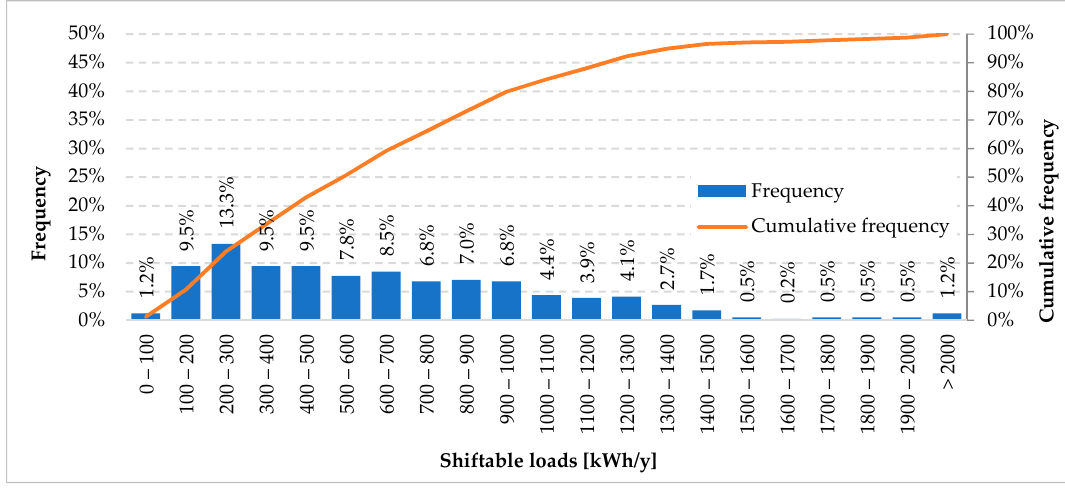
Figure 12. Flexible loads. 3.4. Evolutionary Scenarios Hailing from Small Maintenance Interventions